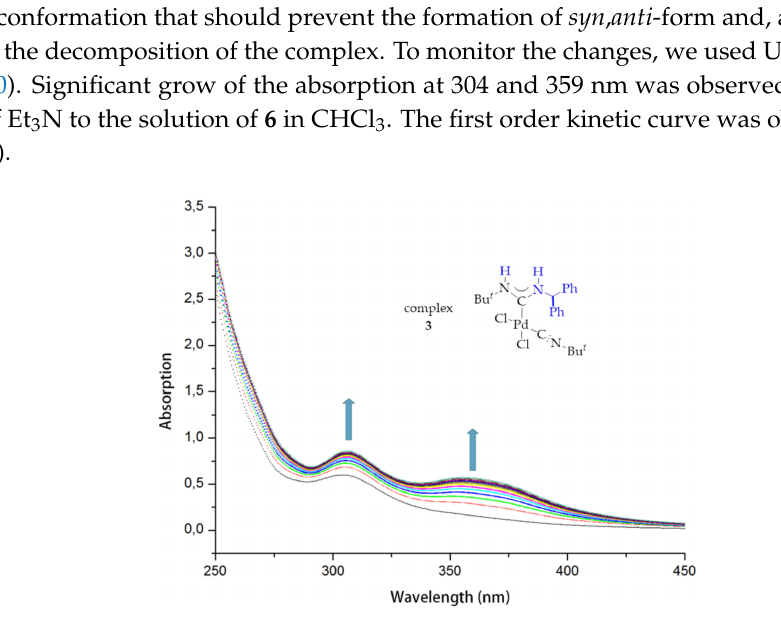
Figure 10. UV-spectra of 6 in CHCl 3 recorded during 1000 s after addition of 10 equiv. of Et 3 N.